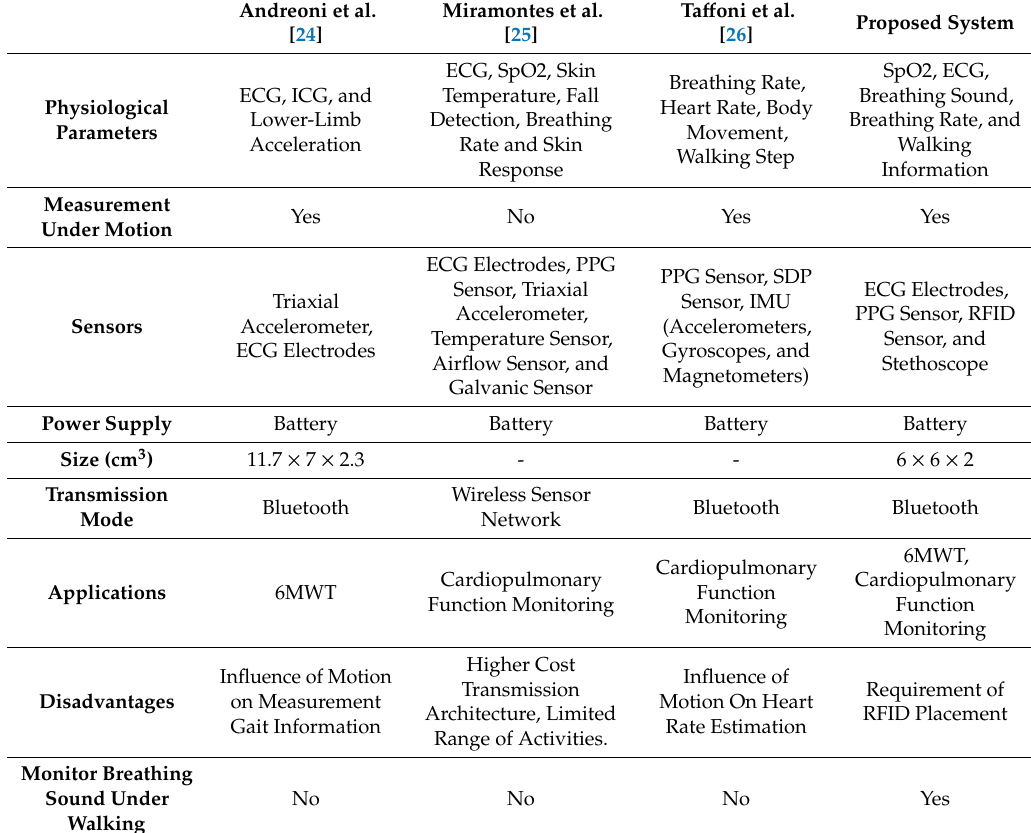
Table 3. System comparison between the proposed system and other systems. Andreoni et al. Miramontes et al. Ta ff oni et [24] [25]